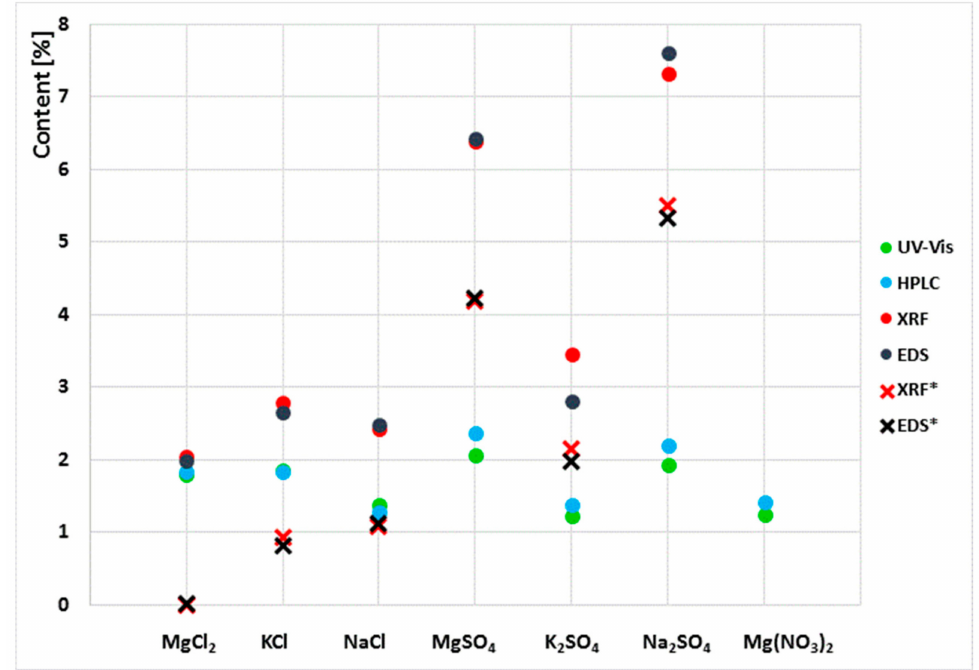
Figure 3. Results of chloride and sulphate ion content determined by liquid chromatography and chlorine and sulphur content determined by XRF and EDS. (*) denotes the results of the determination of the chlorine and sulphur content in the sediment after the leaching of sulphates and